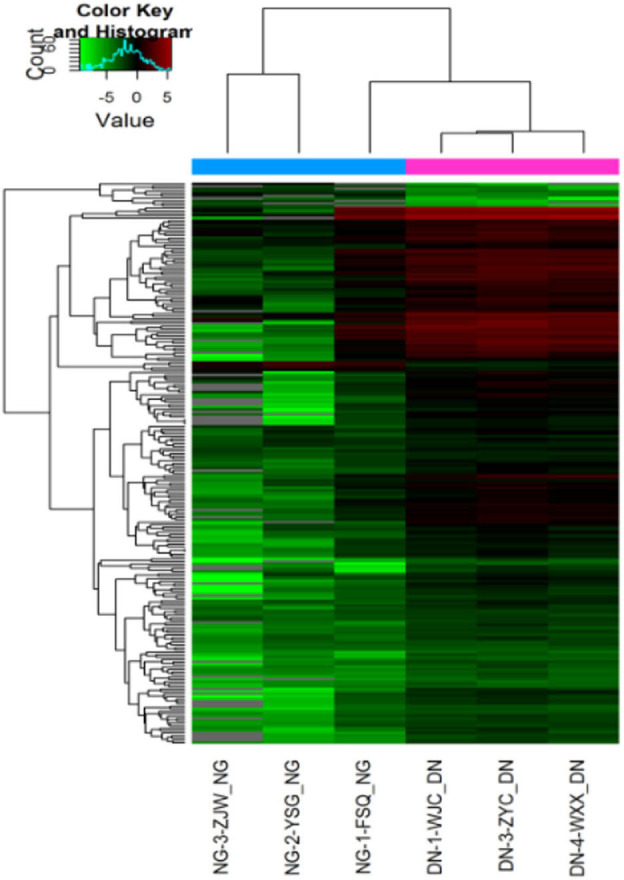
Heat map of expression levels of differentially expressed miRNAs in DKD patients in the screening cohort. Fold change of expression levels were normalized to the mean signal intensities of healthy controls. Red and green colors respectively represent the up- and down-regulation of fold change, as indicated by the linear scale bar.